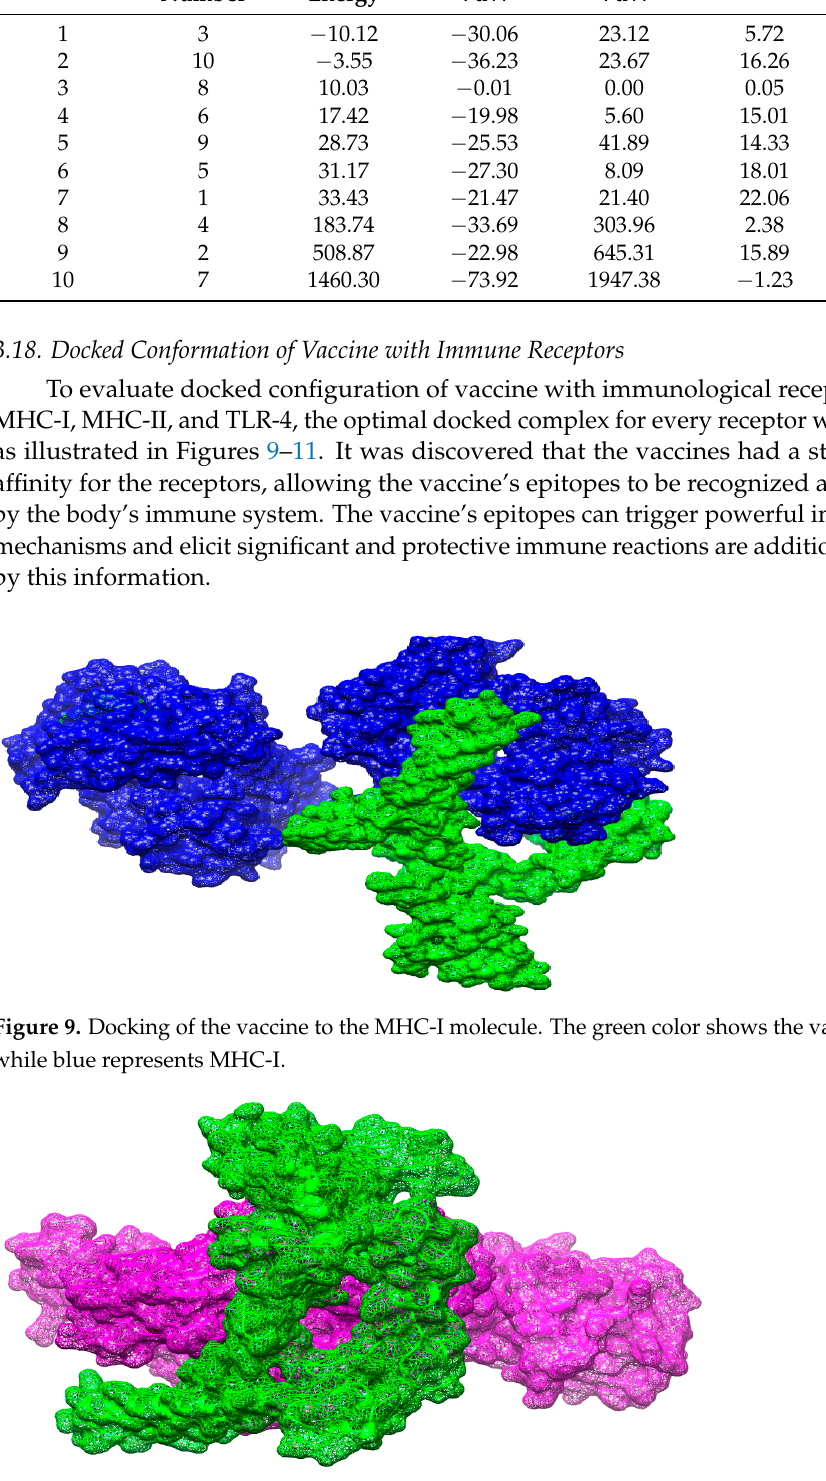
Figure 10. Docking of the vaccine to the MHC-II molecule. The green color shows the vaccine molecule and pink represents MHC ‐ II.